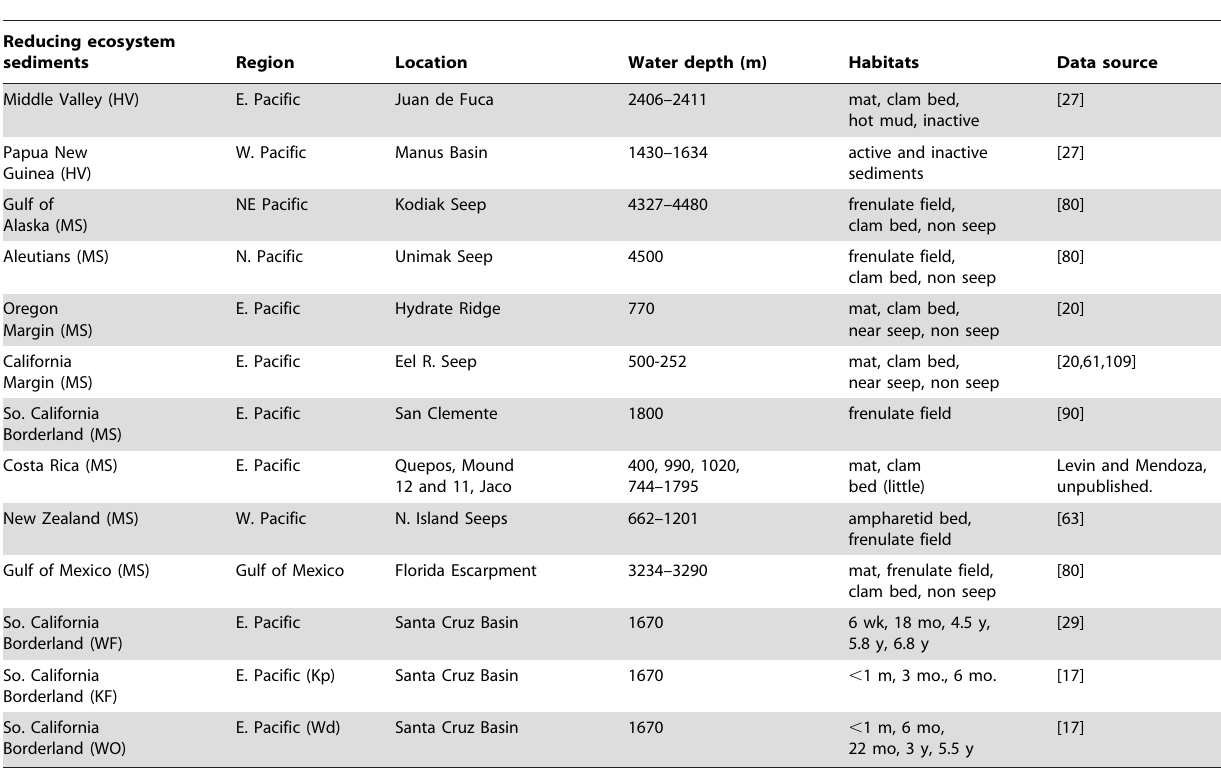
Table 1. Global chemosynthetic ecosystems and study sites where sediment macrofaunal data were available and analyzed in this